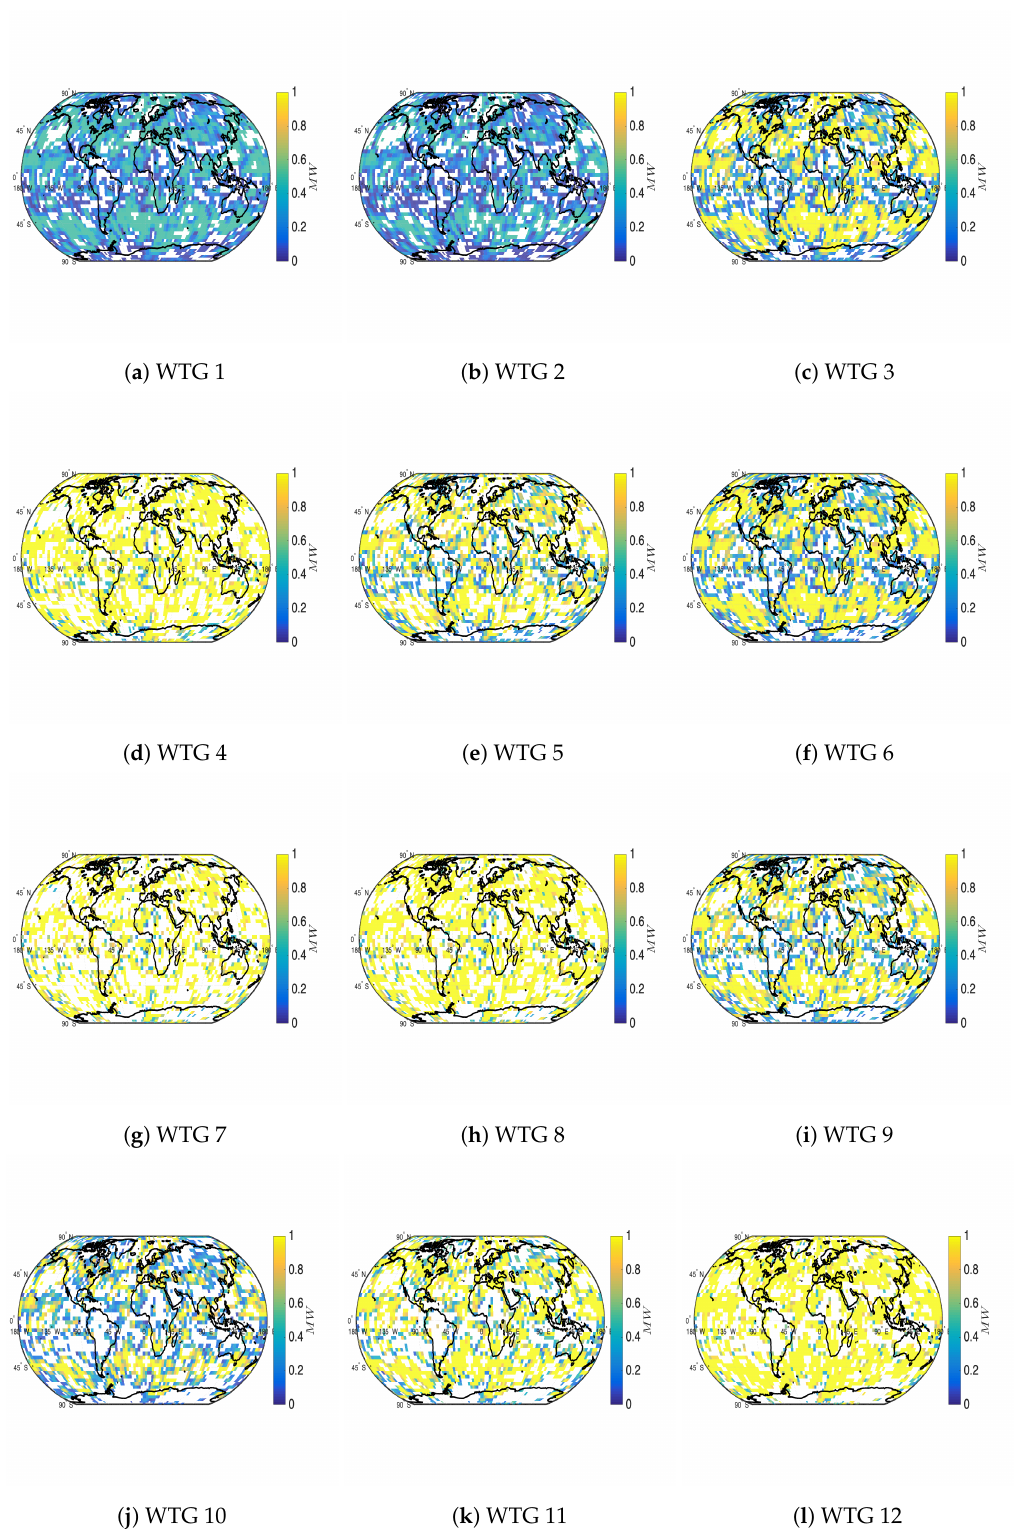
Figure 7. Mean of wind energy potentials for the 4D-Var-MC implementations. The number of ensemble members N = 20. White regions denote no wind-energy-potential generation. The number of observations reads 1. ( a ) WTG 1; ( b ) WTG 2; ( c ) WTG 3; ( d ) WTG 4; ( e ) WTG 5; ( f ) WTG 6; ( g ) WTG 7; ( h ) WTG 8; ( i ) WTG 9; ( j ) WTG 10; ( k ) WTG 11; ( l ) WTG